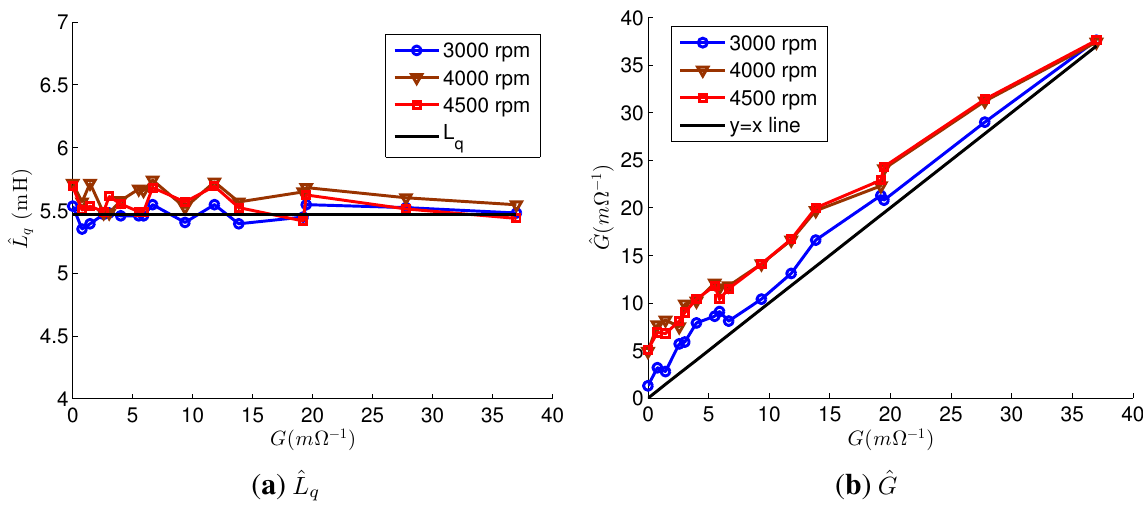
Figure 9. Estimation results of parameter estimation using inaccurate parameters. ( a ) ˆ L